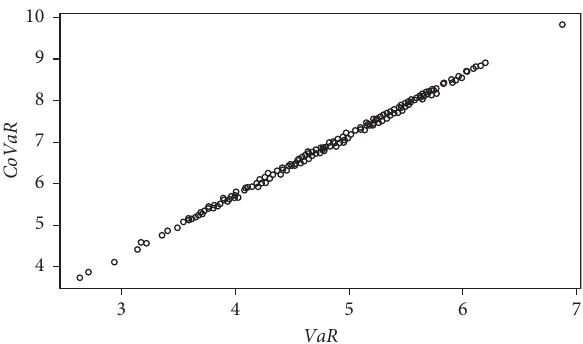
Figure 9: Scatter plot of VaR and CVaR .